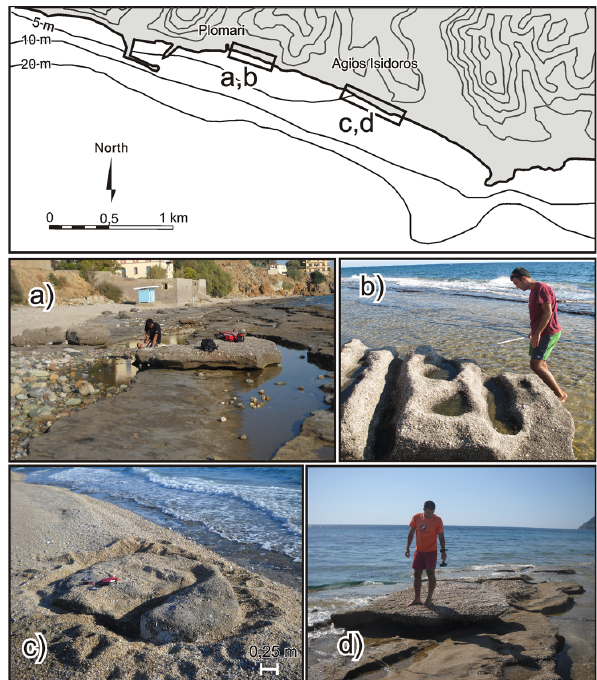
Fig. 2. Topographic sketch of the surveyed sites; (a) and (b) exam- ples of large boulders mapped in the site of Plomari; (c) and (d) ex- amples of large boulders mapped in the site of Agios